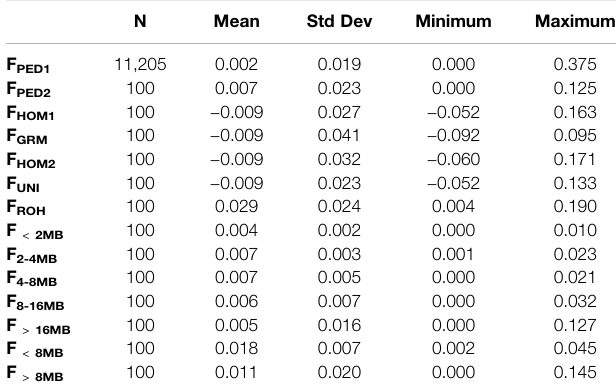
N: number of individuals analyzed; Mean: average of inbreeding coef fi cient; Std Dev: standard deviation. F PED1 :inbreedingcoef fi cientbasedonthepedigreeforallindividualinthePurunãbreed. F PED2 : inbreeding coef fi cient based on the pedigree for Purunã genotyped individuals. F HOM1 : inbreeding coef fi cient based on the number of observed and expected homozygous genotypes. F GRM : inbreeding coef fi cient based on additive genotypic variance. F HOM2 : inbreeding coef fi cient based on homozygosity of genotypes. F UNI : inbreeding coef fi cient based on the correlation between uniting gametes. F ROH : inbreeding coef fi cient based onthe length of the ROH ’ s and the total length of the autosomal